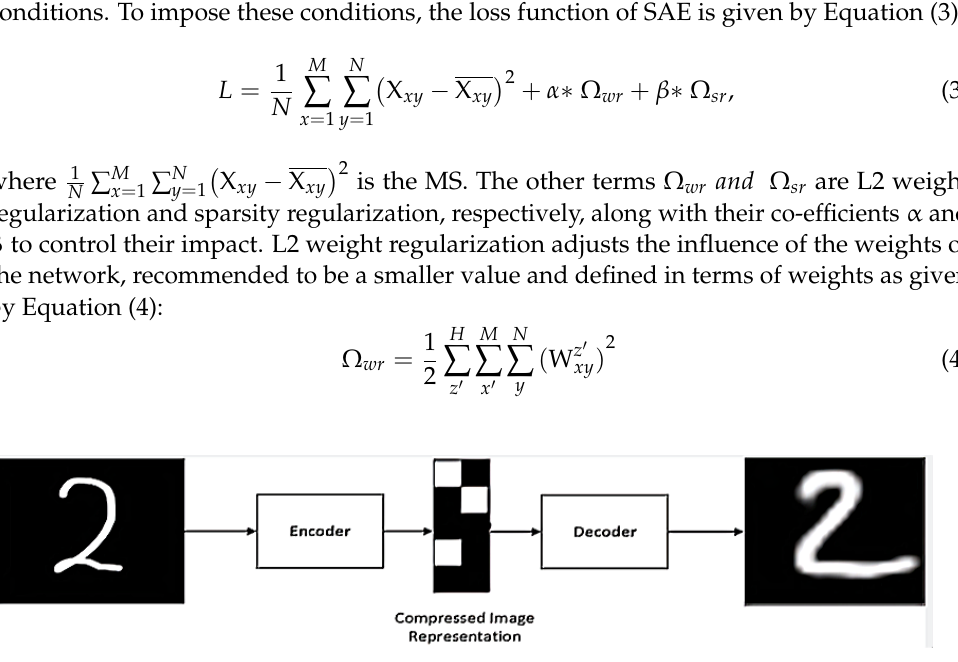
Figure 7. Architecture of deep-sparse auto-encoder (SAE). Here, H , M , and N are the number of hidden layers, the number of examples, and the number of actually used variables in the data, respectively. This L2 weight regularization is the major source for good generalization. Another constraint, Sparsity Regularization, helps to panelize the sparsity of the output connections from the hidden layer as given by Equation (5):